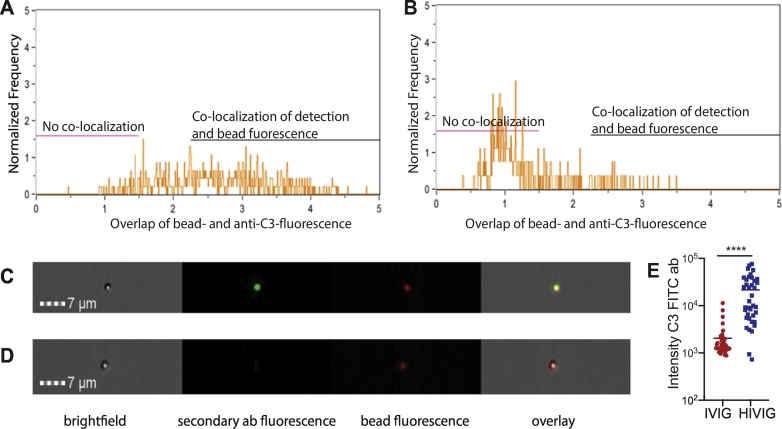
Image stream analysis confirms the detection of complement deposition on fluorescent beads. 5 mg/ml of HIVIG (pooled IgG from HIV-infected individuals as positive control) and IVIG (pooled IgG from healthy individuals as negative control) were used as samples for the detection of complement-activating antibodies against the HIV gp120 antigen. After completing the bead-based complement deposition assay, samples were run on the Amnis ImageStreamX imaging flow cytometer in order to quantify the fluorescence of the fluorescent bead and the detection antibody. The overlay of bead fluorescence and secondary antibody color is depicted in panels A and B. Panels C and D show representative microscopy pictures. A: HIVIG shows a broad overlap of the two fluorescent channels with the spread of co-localization on the x-axis representing the differences in FITC fluorescence. B: IVIG sample shows a low amount of co-localization between bead and secondary antibody fluorescence. C: HIVIG as a sample gives both bead and complement fluorescence, that co-localize as shown in the overlay. D: IVIG does not induce complement deposition on the HIV-bead and therefore only the bead fluorescence is visible. E: Intensity of secondary antibody fluorescence for IVIG and HIVIG for 40 beads is shown. Mann-Whitney test was performed, ****p < 0.0001.